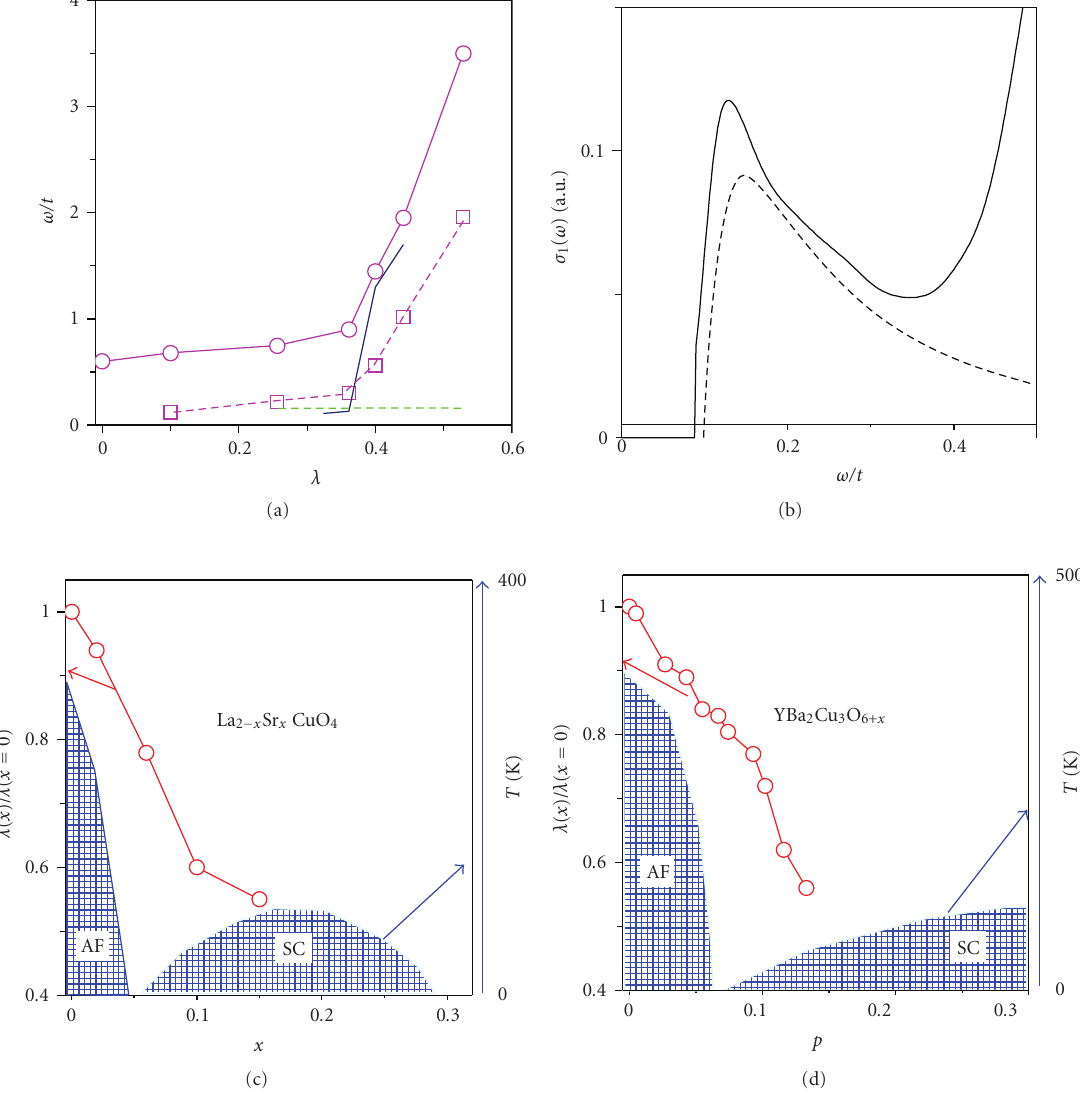
Figure 11: (a) Energies of the dominant MIR peak (solid line with circles) and low-energy peak (dashed line with squares) of the t-J-H model versus λ . Energies of the dominant peaks of the Holstein model for t = 1 (dashed line) and for (cid:6) t = 0 . 4 (solid line). (b) OC of the t-J-H model (solid line) and e ff ective Holstein model with (cid:6) t = 0 . 4 (dashed line). Both OC are for λ = 0 . 1. (c) and (d) Ratio of the e ff ective coupling constants on doping x (or real concentration p of the hole in plain for YBCO [244]) and that at almost zero doping. E ff ective λ ( x ) is determined by the fit of the MIR position at given